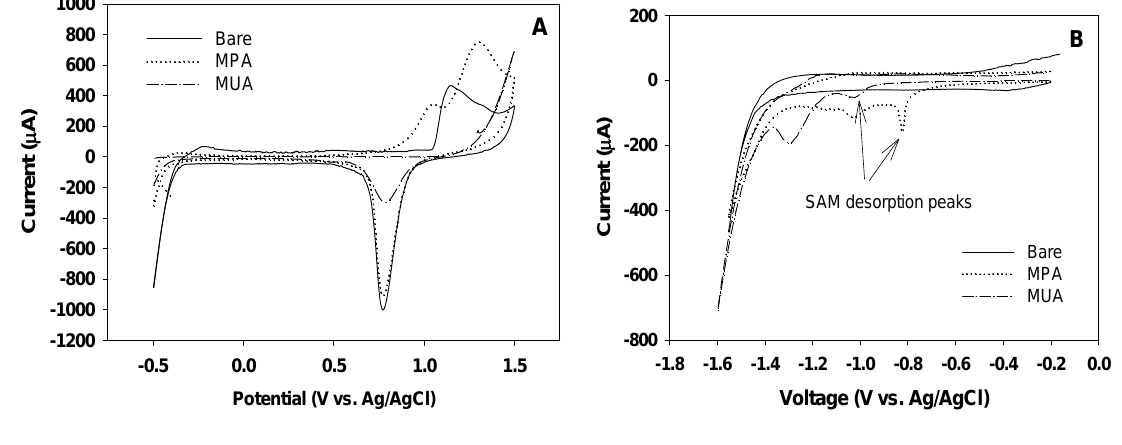
Figure 3. (A) CV curves obtained for the bare and MPA and MUA treated 3D electrodes in quantifying the percent defect in SAM molecules in electrolyte containing 0.1 M H (B) CV curves obtained for the bare and MPA and MUA treated 3D electrodes in evaluating SAM desorption in electrolyte containing 0.1M